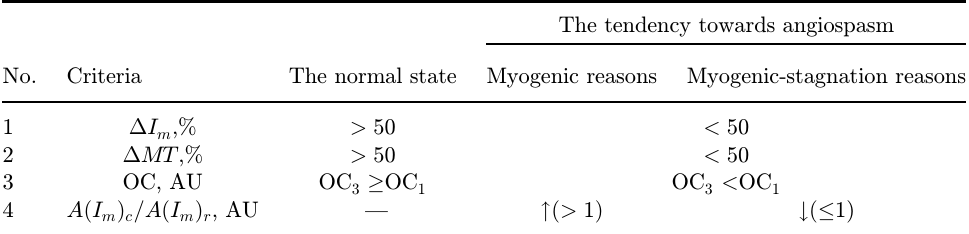
Table 2. The proposed criteria of the normal state and the tendency to angispasm, as well as the possible causes of